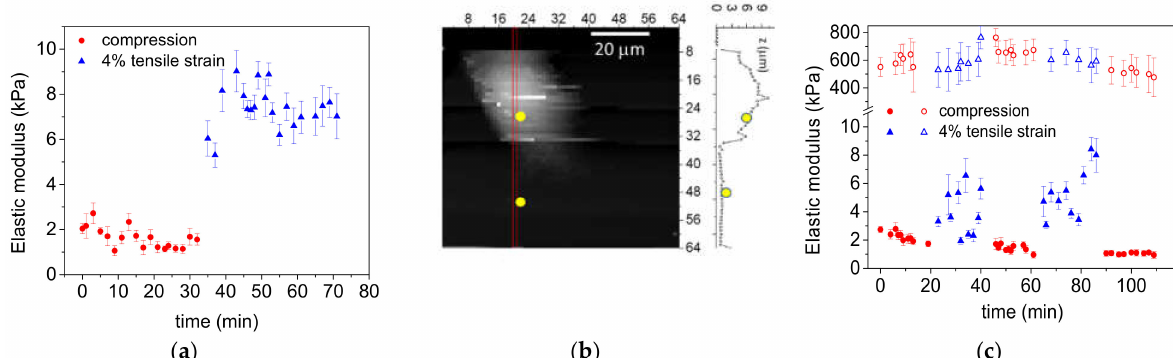
Figure 10. Elastic modulus of fibroblasts subjected to step-like voltage changes as a function of time, before and after uniaxial compression-stretching (4% strain). Each elasticity data point shows the mean value and standard deviation calculated from 8 × 8 indentation curves across an area of 500 × 500 nm 2 . ( a ) Cell elastic modulus during one compression-stretching cycle. ( b ) Topography image of a single 3T3 cell obtained from a 64 × 64 force map and height profile corresponding to the red line. The yellow dots correspond to the two areas probed to calculate the elasticity values reported in ( c ). ( c ) Two and a half consecutive compression/stretch cycles. The elasticity values measured on the bare dielectric elastomer are also plotted for comparison (empty